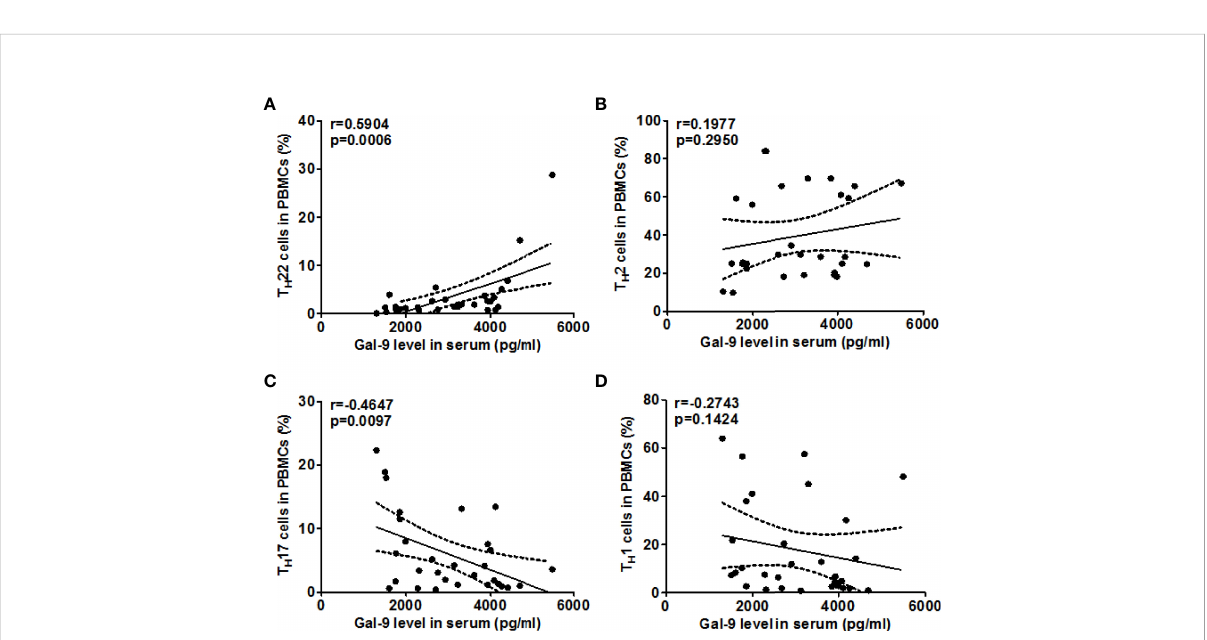
FIGURE 6 The correlation between Gal-9 levels and T H 2/T H 22 as well as T H 1/T H 17 cell ratios in AD. Association of Gal-9 levels and the percentage of TIM-3 + CD4 + T cells and frequency of T H 1 cells (A) , T H 2 cells (B) , T H 17 cells (C) , and T H 22 cells (D) in patients with